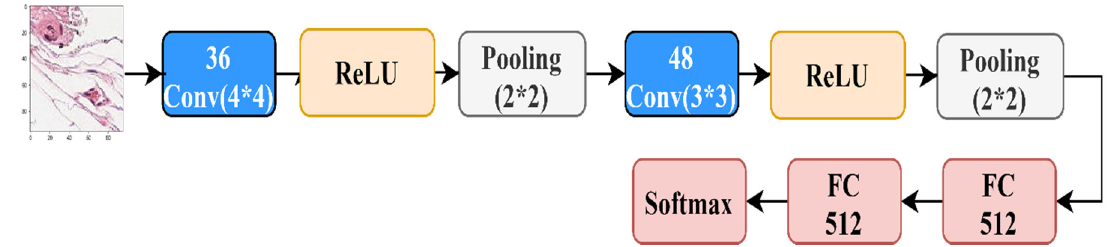
Figure 9. The architecture of Sirinukunwattana et al. [23].